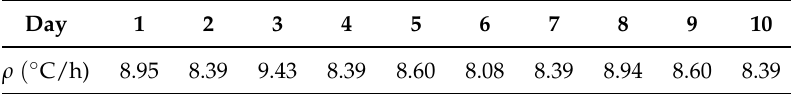
Figure 5. Diagram of the Fibonacci optimization algorithm. Table 2. The optimal controller gains in different